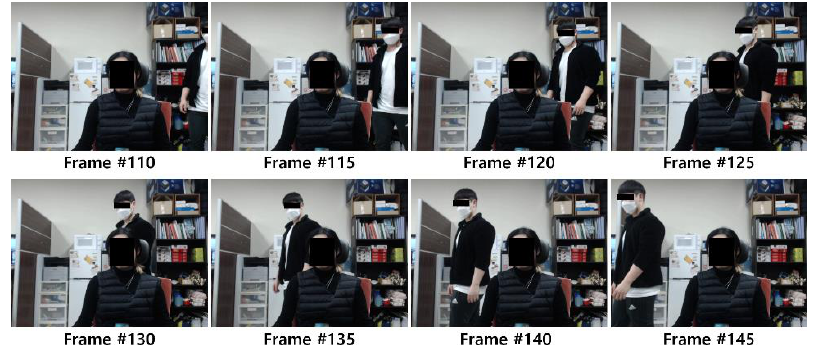
Figure 8. Data samples from Experiment 2 with background noise.